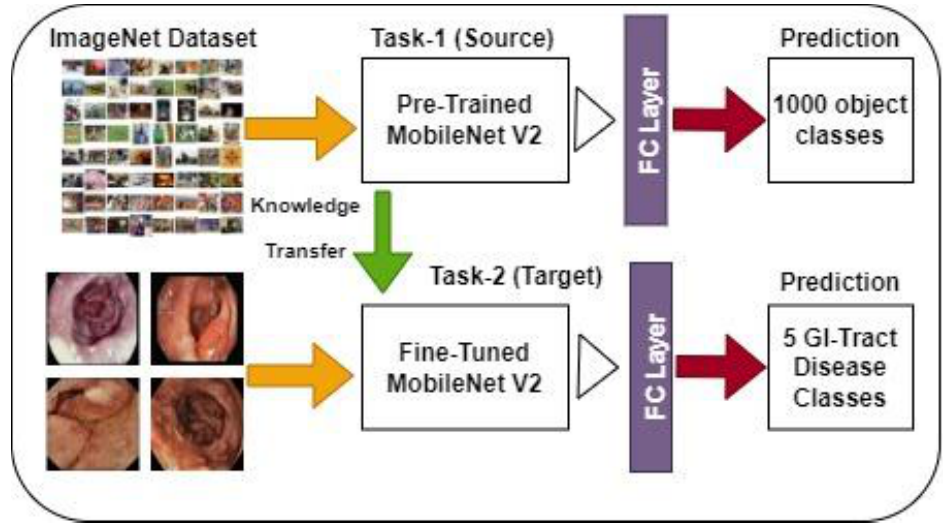
Figure 4. Transfer learning process.